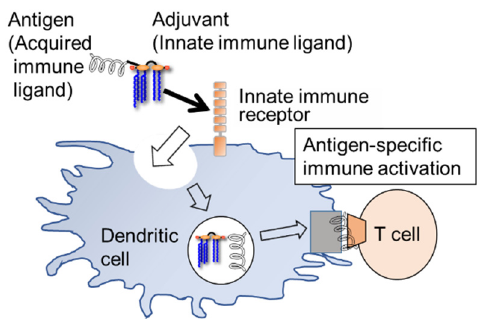
Figure 11. Self-adjuvanting strategy.